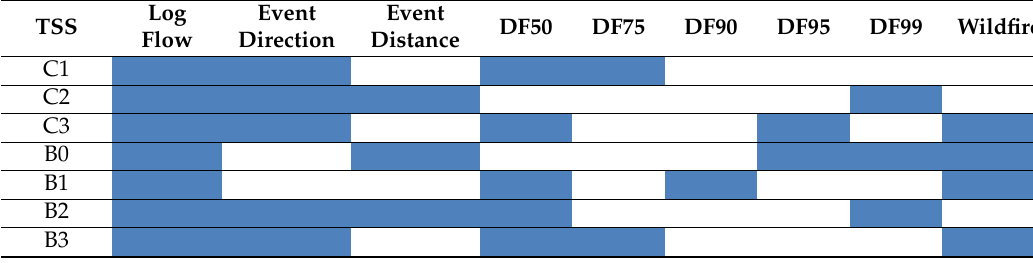
Table 6. Selected predictors for model predicting total suspended solids.